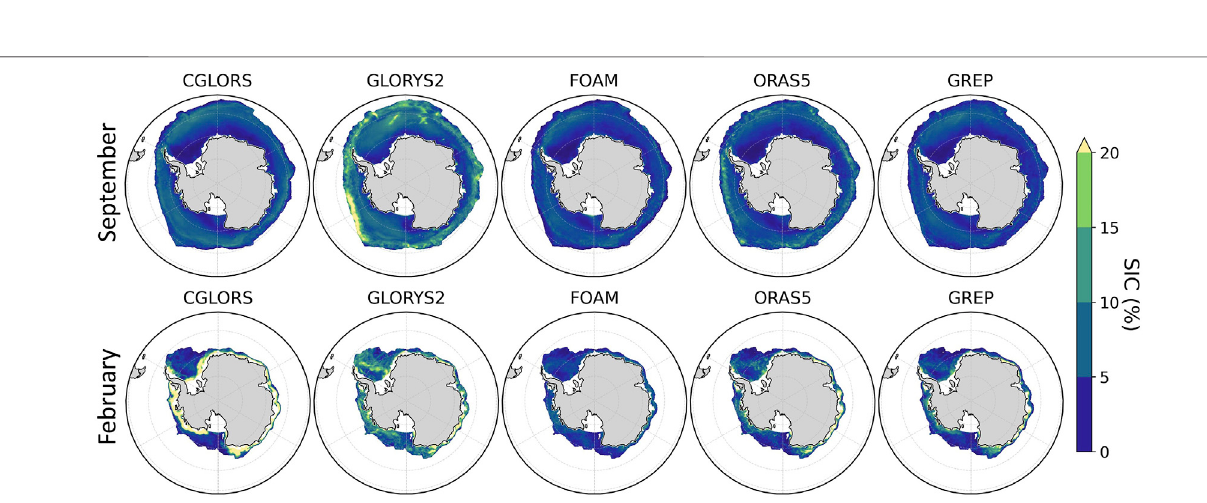
Frontiers in Earth Science |